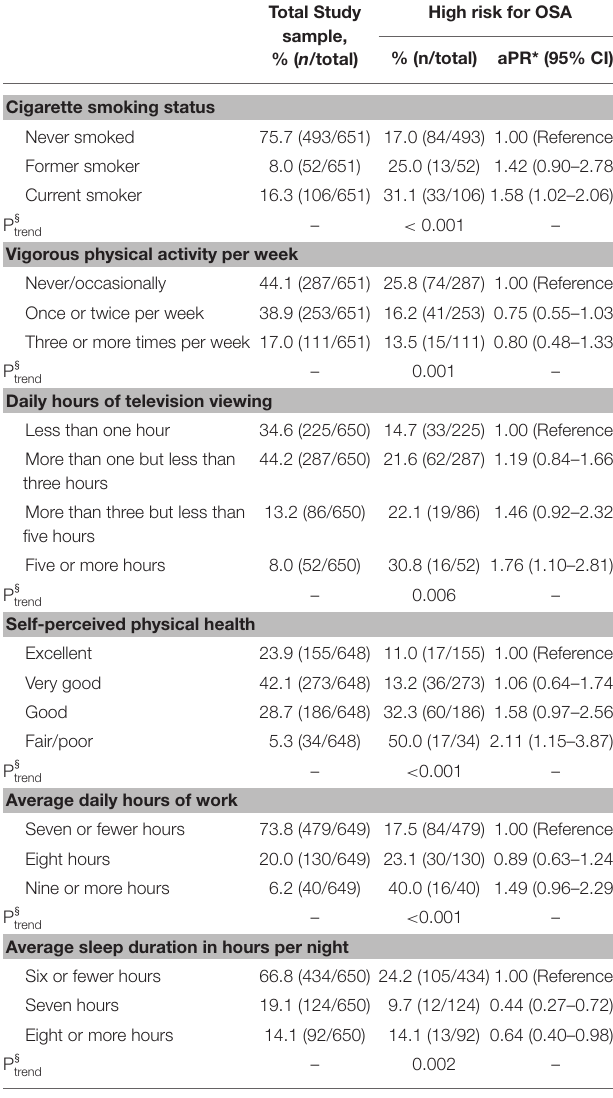
TABLE 2 | Associations of lifestyle (behavioral) factors, perceived physical health, working hours, and sleep duration with risk of obstructive sleep apnea (OSA).